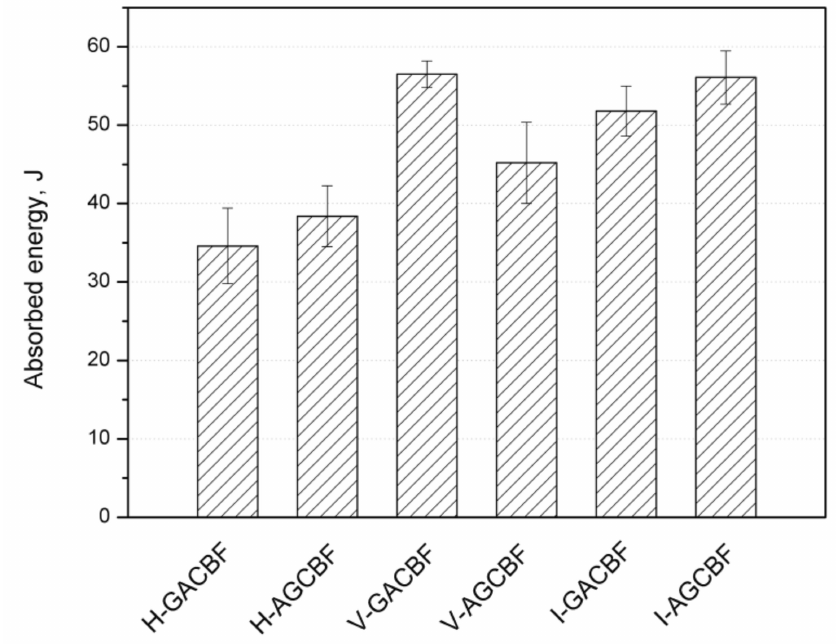
Figure 4. The absorbed energy of EP hybrid composites measured by drop